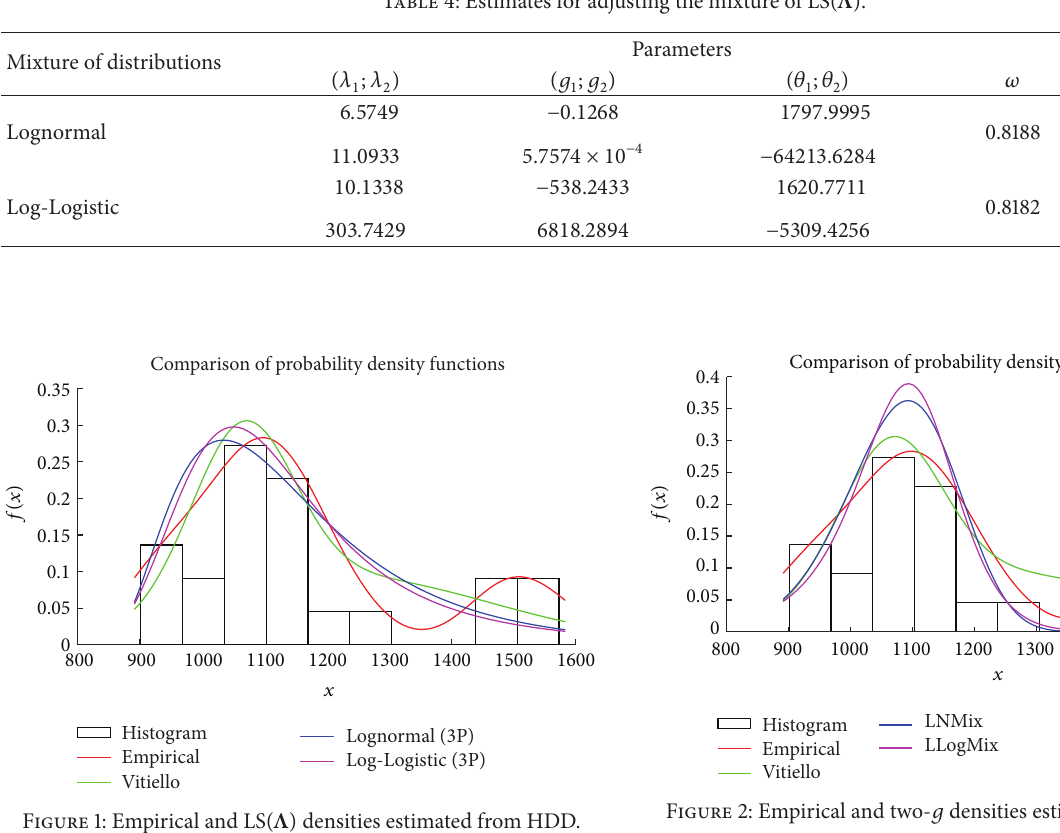
Table 4: Estimates for adjusting the mixture of LS ( Λ ) .